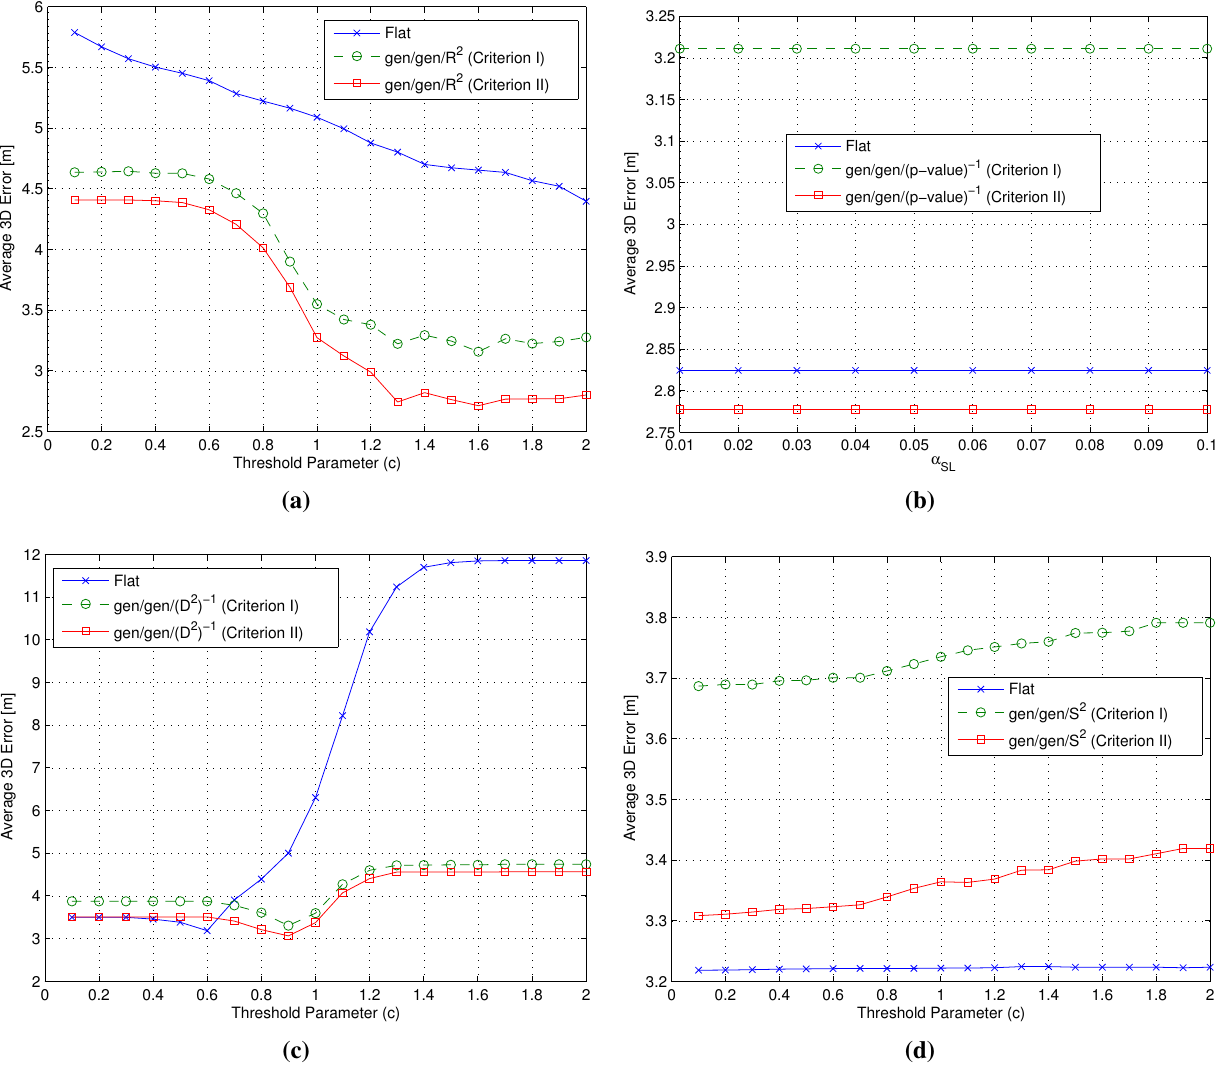
Figure 7. Impact of the matching cluster Criteria I/II on the average 3D error ¯ (cid:15) . ( a ) flat vs. gen/gen/ R 2 combinations; ( b ) flat vs. gen/gen/ ( p -value ) − 1 combinations; ( c ) flat vs. gen/gen/ ( D 2 ) − 1 combinations; ( d ) flat vs. gen/gen/ S 2